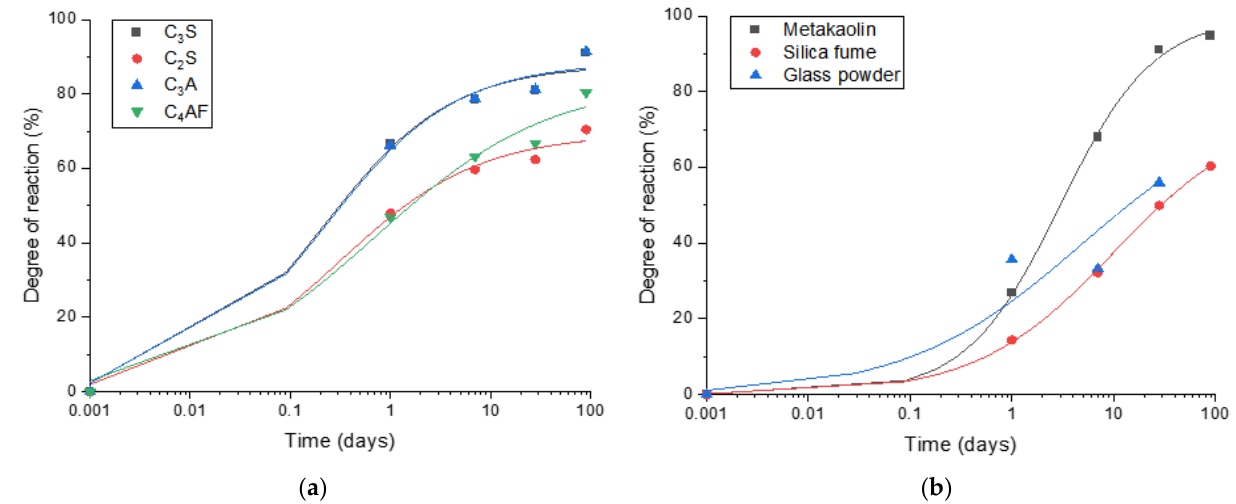
Figure 4. The reaction degrees of cement clinkers and SCMs using the amount of portlandite obtained by TGA and thermodynamic calculations: ( a ) Reaction degrees of cement clinkers predicted by thermodynamic calculation; ( b ) Reaction degrees of SCMs estimated using thermodynamic modelling. Table 4. The fitted parameters for simulating the curves shown in Figure 3.